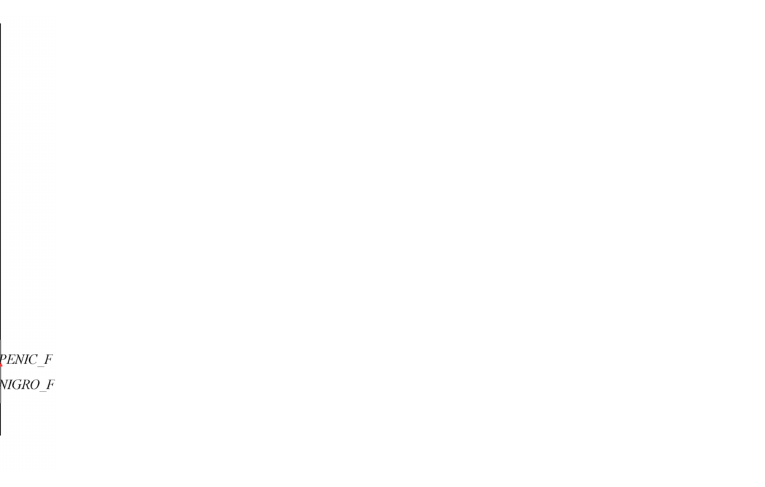
Figure 2. Affinities to shells of specific gastropod species: TRIP_F = Pellenes tripunctatus female, TRIP_M = Pellenes tripunctatus male, NIGRO_F = Pellenes nigrociliatus female, NIGRO_M = Pellenes nigrociliatus male, PENIC_F = Attulus penicillatus female.